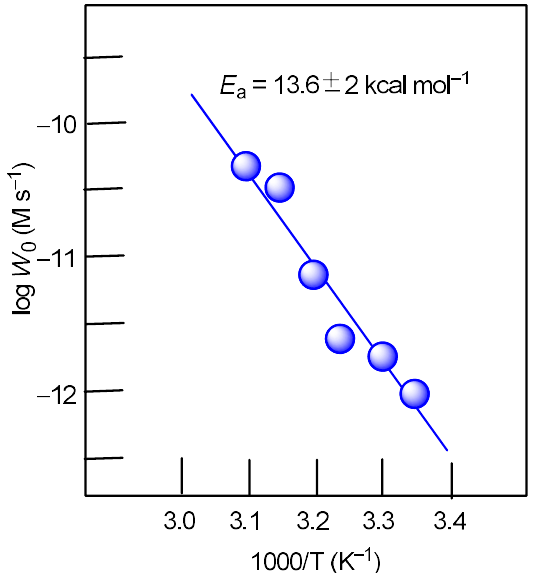
Figure 7. The Arrhenius plot of the oxidation of cyclohexane (0.46 M) with H 2 O 2 (50%, 2 M), catalyzed by compound 1 (5 × 10 −4 M) in acetonitrile, in the presence of HNO 3 (0.05 M). Concentrations of products were measured by GC after the reduction of the reaction sample with solid PPh 3 .